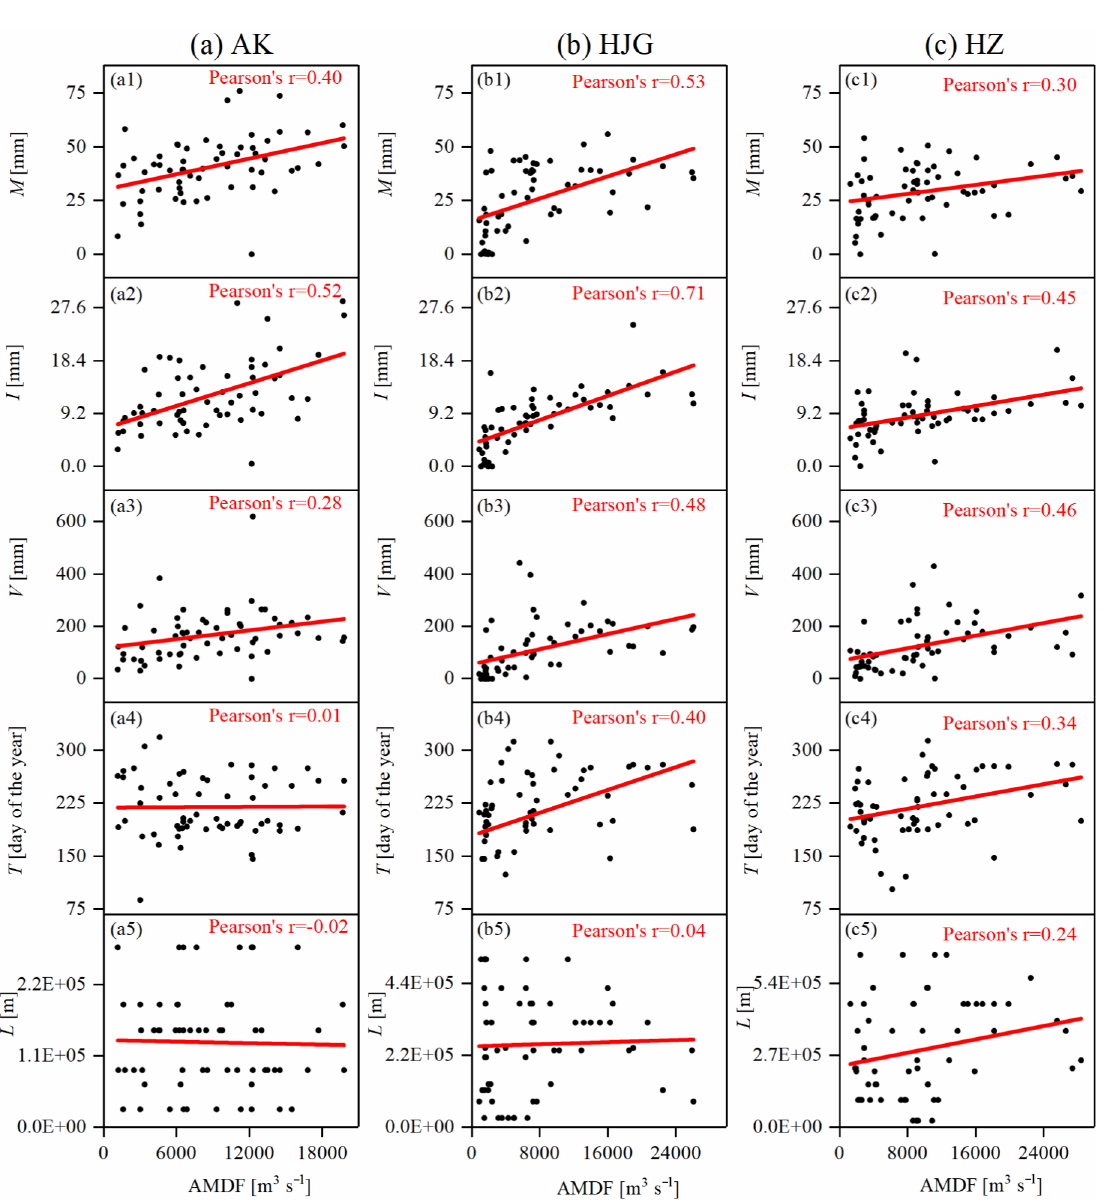
Figure 5. Linear correlation between the five MARI variables and the AMDF for (a) the AK station, (b) the HJG station, and (c) the HZ